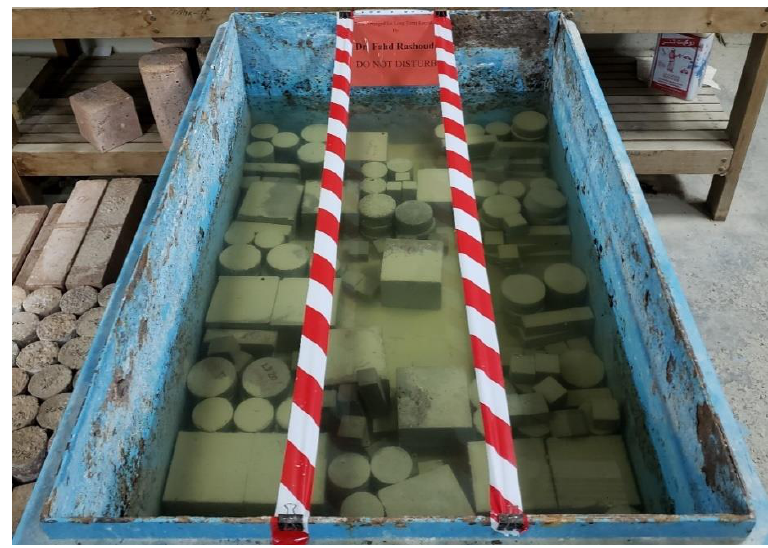
Figure 1. Curing condition of proposed mortar specimens. Table 1. Mortar mix design of rPP as a fine aggregate replacement (c/a = 1:3 and c/w = 2:1).